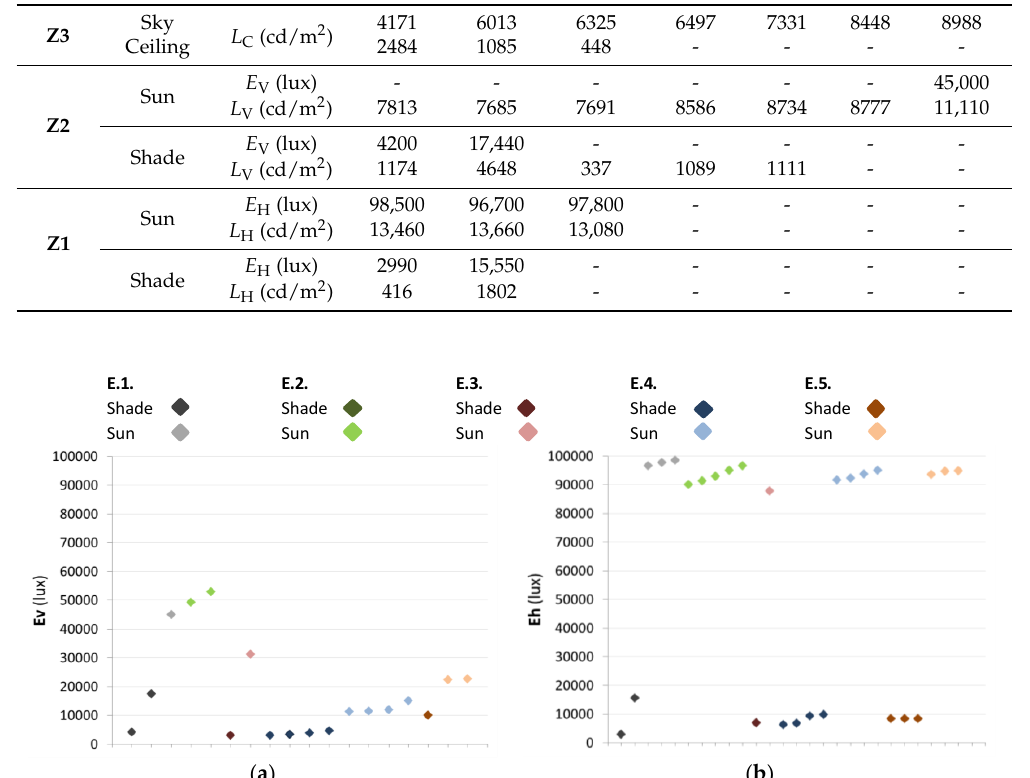
Figure 2. ( a ) Street points’ illuminance (lux) in Zone 2; and ( b ) street points’ illuminance (lux) in Zone 1 for Cases E.1–E.5.